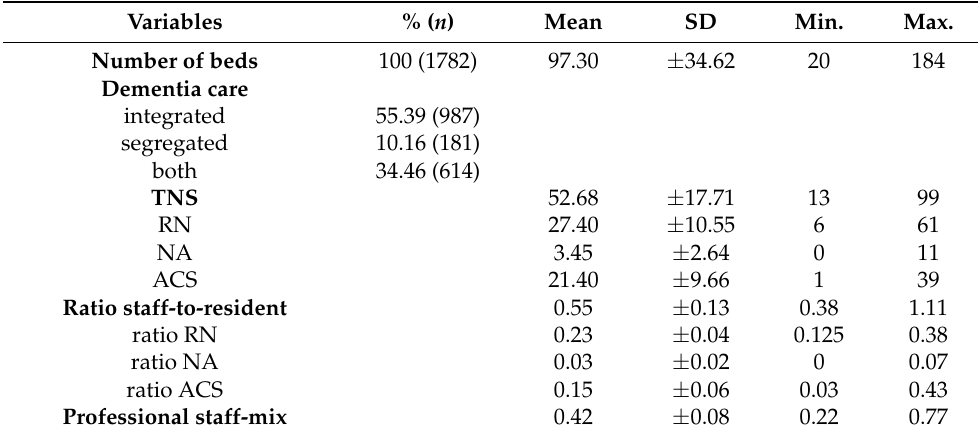
Table 2. Descriptive characteristics at the facility